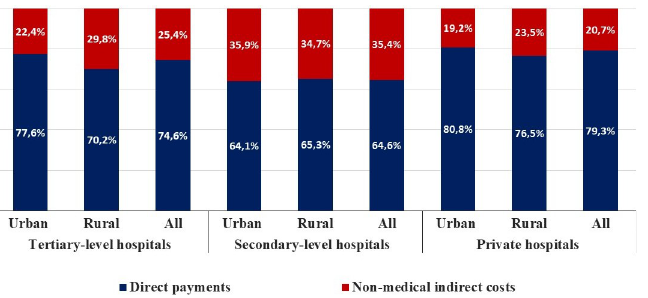
Fig 2. Structures of average out-of-pocket payments for inpatient care by different levels and types of hospitals in Mongolia.